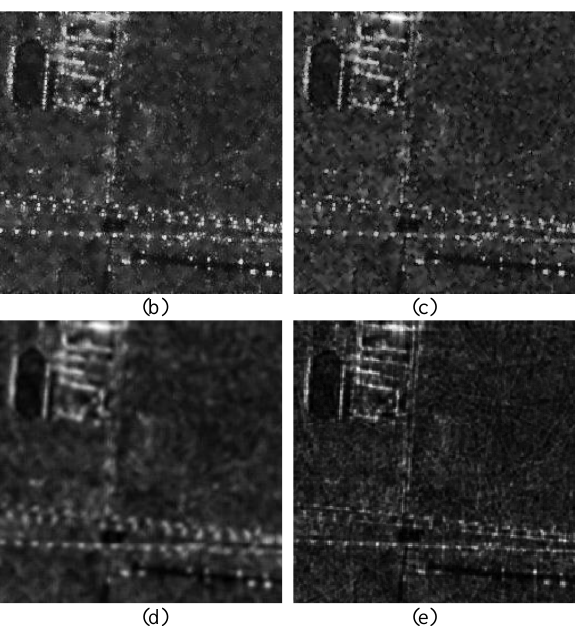
Fig 5. Despeckling results: (a) original image, (b) Lee filter, (c) Gamma MAP filter, (d) improved non-local means, (e) our method.